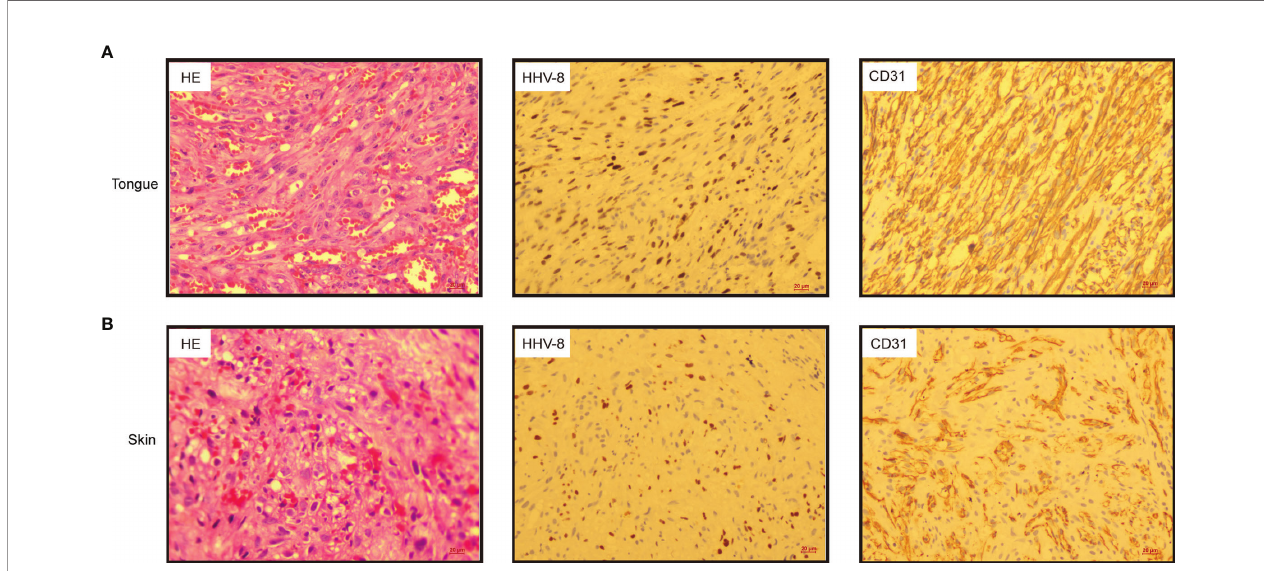
FIGURE 2 | Histologic sections from tongue (A) and skin of the right arm (B) exhibited spindle cell proliferation in bundles, extravasated red blood cells and hyaline globules. (Left panel, haematoxylin & eosin, HE 20×); Immunohistochemistry indicated that the tumour cells were positive for human herpesvirus 8 (HHV-8) (middle panel, HHV-8 20×) and CD31 (right panel, CD31